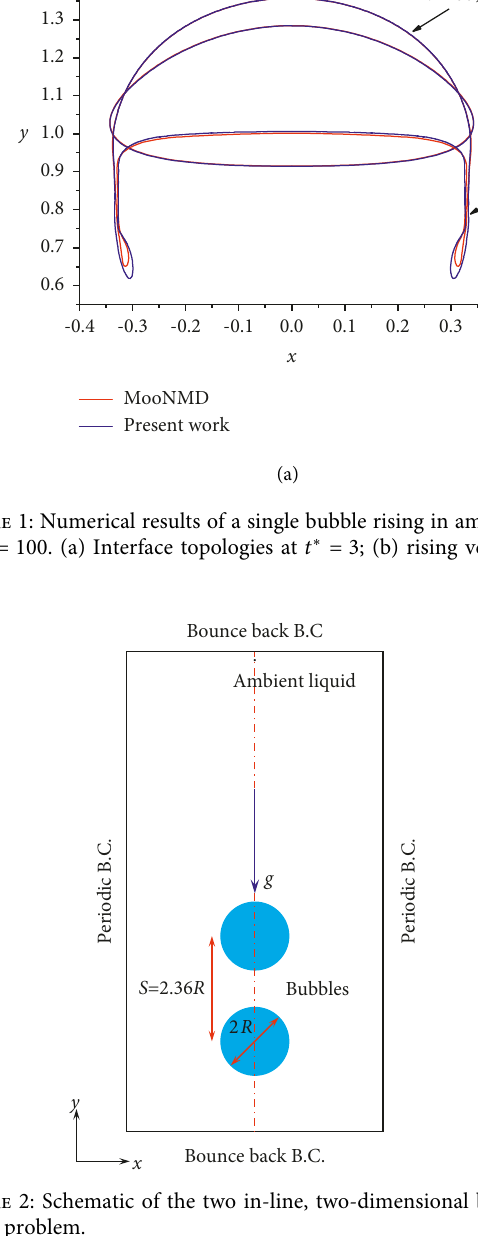
Figure 2: Schematic of the two in-line, two-dimensional bubbles rising problem.